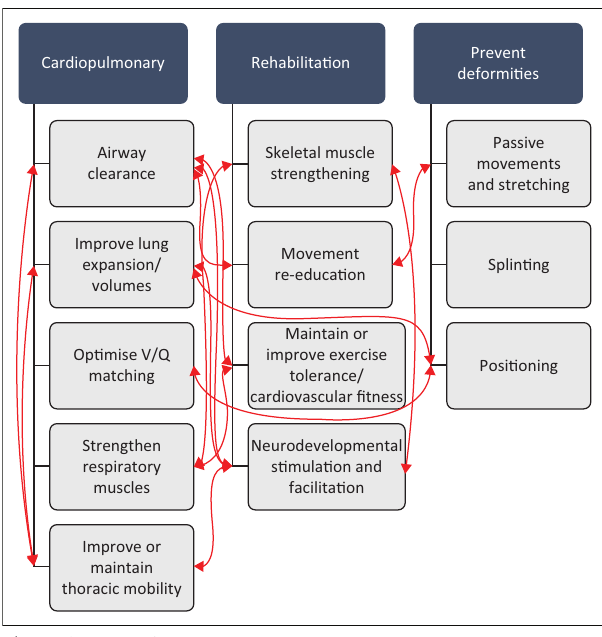
FIGURE 2: Selected examples of the inter-relationships among different systems and physiotherapeutic interventions in infants and